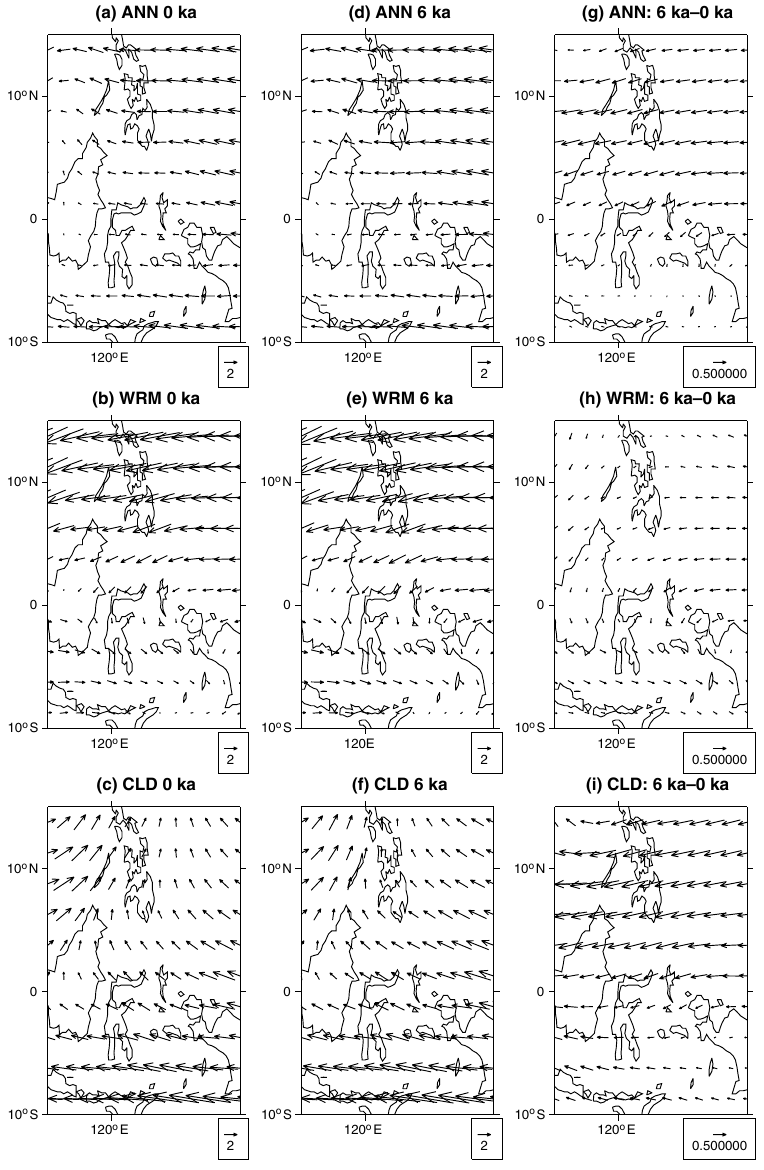
Figure 6. The multi-model mean circulation over the tropical north-west (TNW) domain for the 0ka simulations’ (a) annual mean (ANN), (b) October–March (WRM, i.e. warm season) mean and (c) April–September (CLD, i.e. cold season) mean. Corresponding figures for the 6ka simulations are plotted in (d–f) with the differences ( d minus a , e minus b and f minus c ) plotted in (g–i) ,